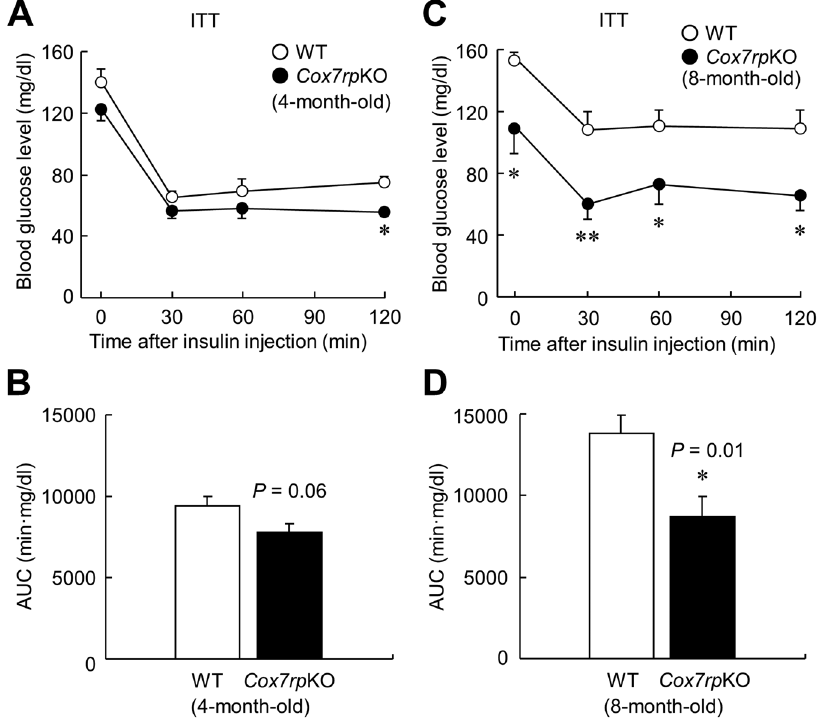
Figure 4. Lower blood glucose levels in 4- and 8-month-old Cox7rp KO mice versus WT mice during insulin tolerance test (ITT). Cox7rp KO and WT mice at 4-month-old and 8-month-old were fasted for 1 h, then injected intraperitoneally with insulin (0.5 U/kg body weight). Blood glucose level ( A ) and the AUC ( B ) in ITT at 4-month-old. Blood glucose level ( C ) and the AUC ( D ) in ITT at 8-month-old. Data are presented as means ± SEM ( n = 6). * P < 0.05, ** P < 0.01, using unpaired Student’s t